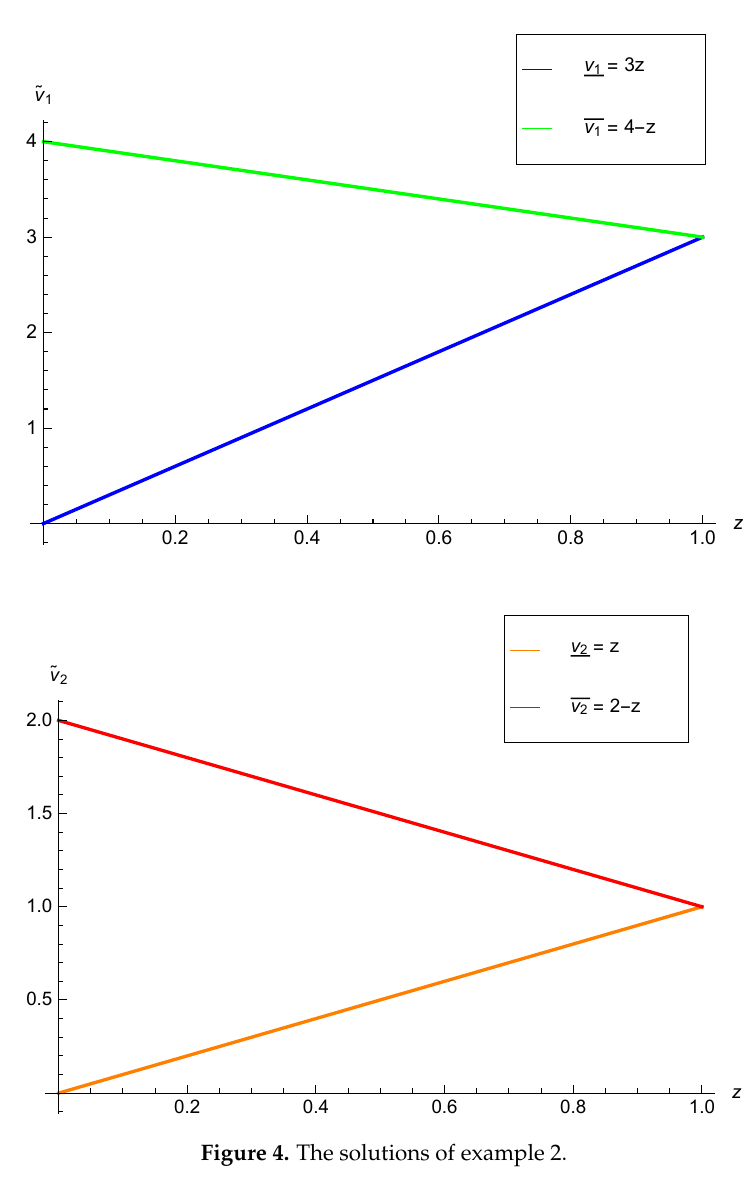
Figure 4. The solutions of example